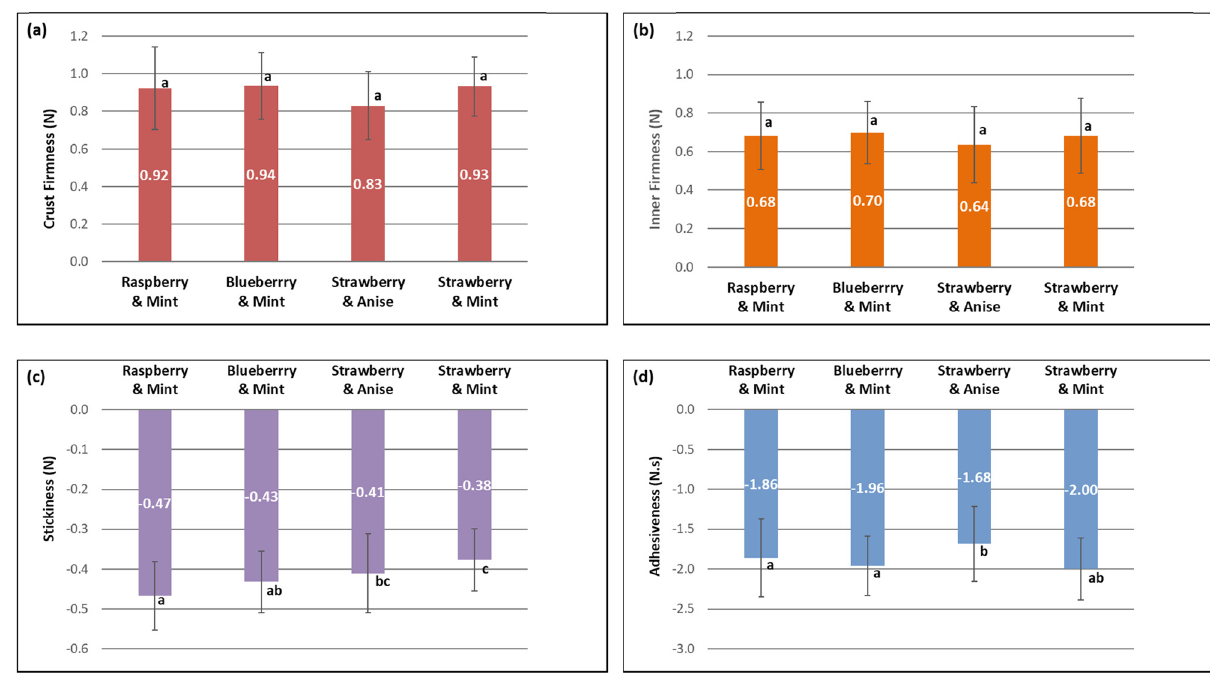
Figure 6: Textural properties of the jelly gums as a whole, obtained by the puncture test: ( a ) crust fi rmness, ( b ) inner fi rmness, ( c ) stickiness and ( d ) adhesiveness ( bars with the same letter are not statistically di ff erent at 5% signi fi cance level – ANOVA with Tukey test ) .